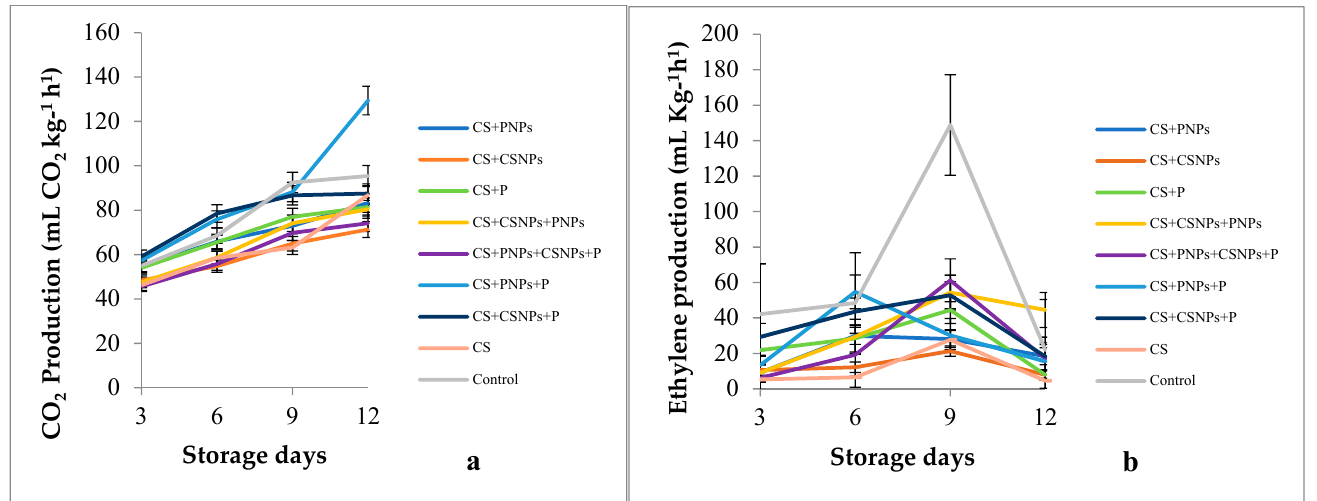
Figure 2. Effect of edible of chitosan/propolis coatings on: ( a ) CO 2 and ( b ) ethylene production of fig fruit stored for 12 days at 4 °C. CS (chitosan), P (propolis extract), CSNPs (chitosan nanoparticles), PNPs (propolis nanoparticles).